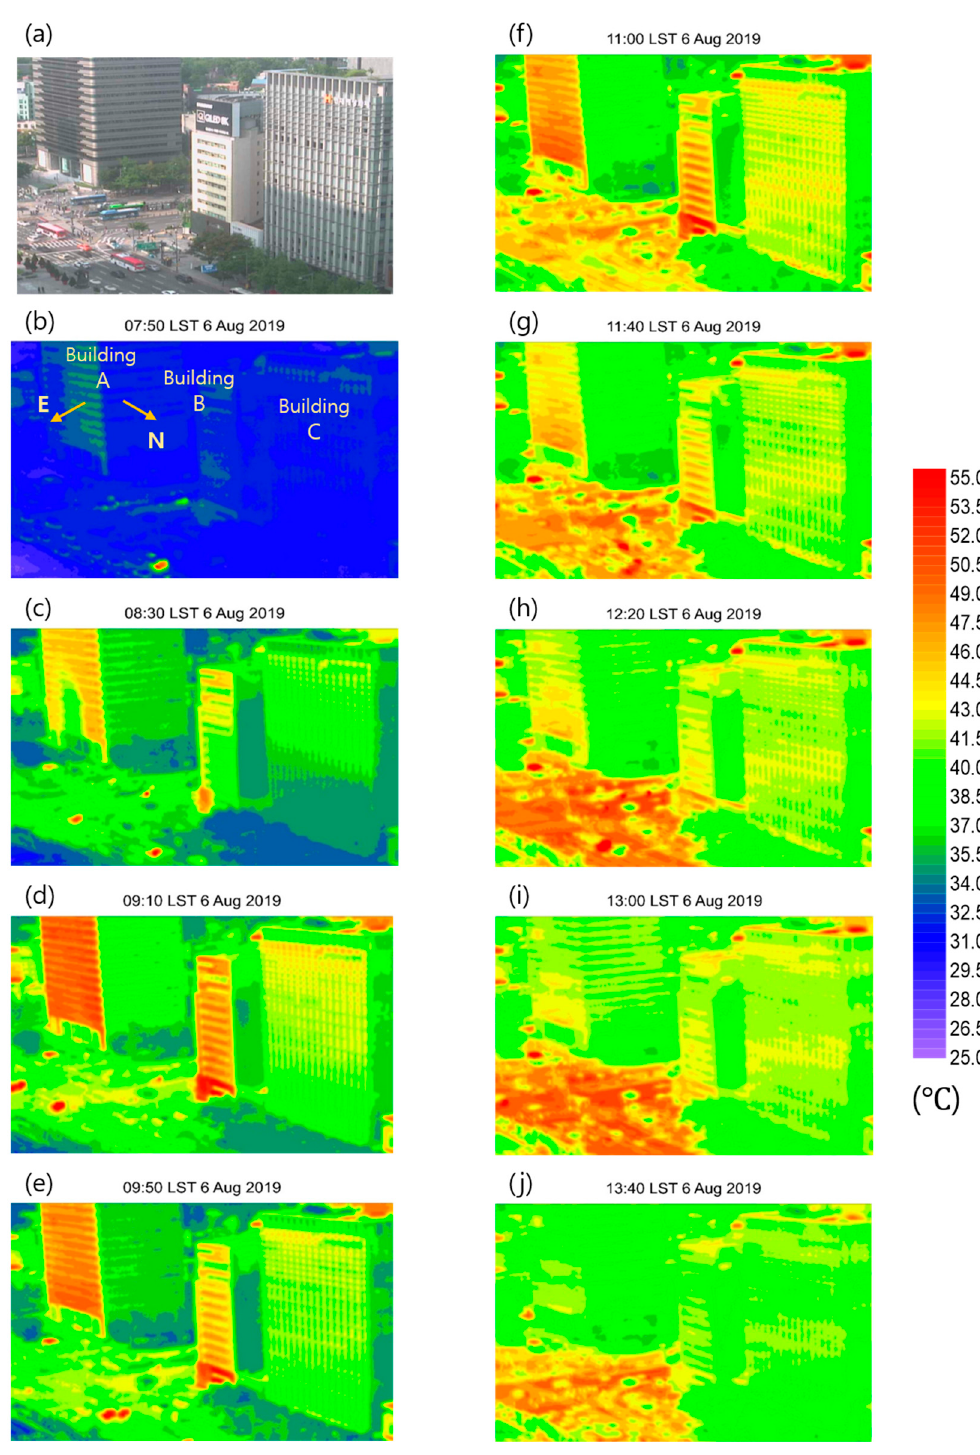
Figure 7. ( a ) Real image corresponding to the view angle of thermal infrared imager at 0830 LST, and horizontal distribution of surface temperature observed by TIR at ( b ) 0750 LST, ( c ) 0830 LST, ( d ) 0910 LST, ( e ) 0950 LST, ( f ) 1100 LST, ( g ) 1140 LST, ( h ) 1220 LST, ( i ) 1300 LST, and ( j ) 1340 LST on 6 August 2019.